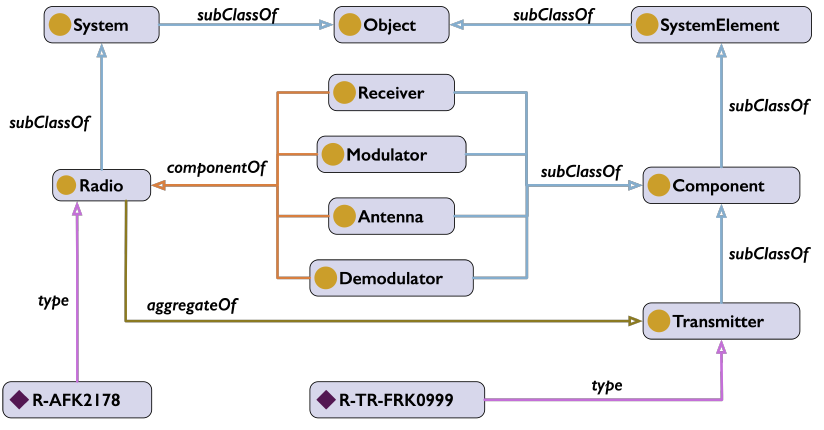
Figure 5. A fragment of the Radio